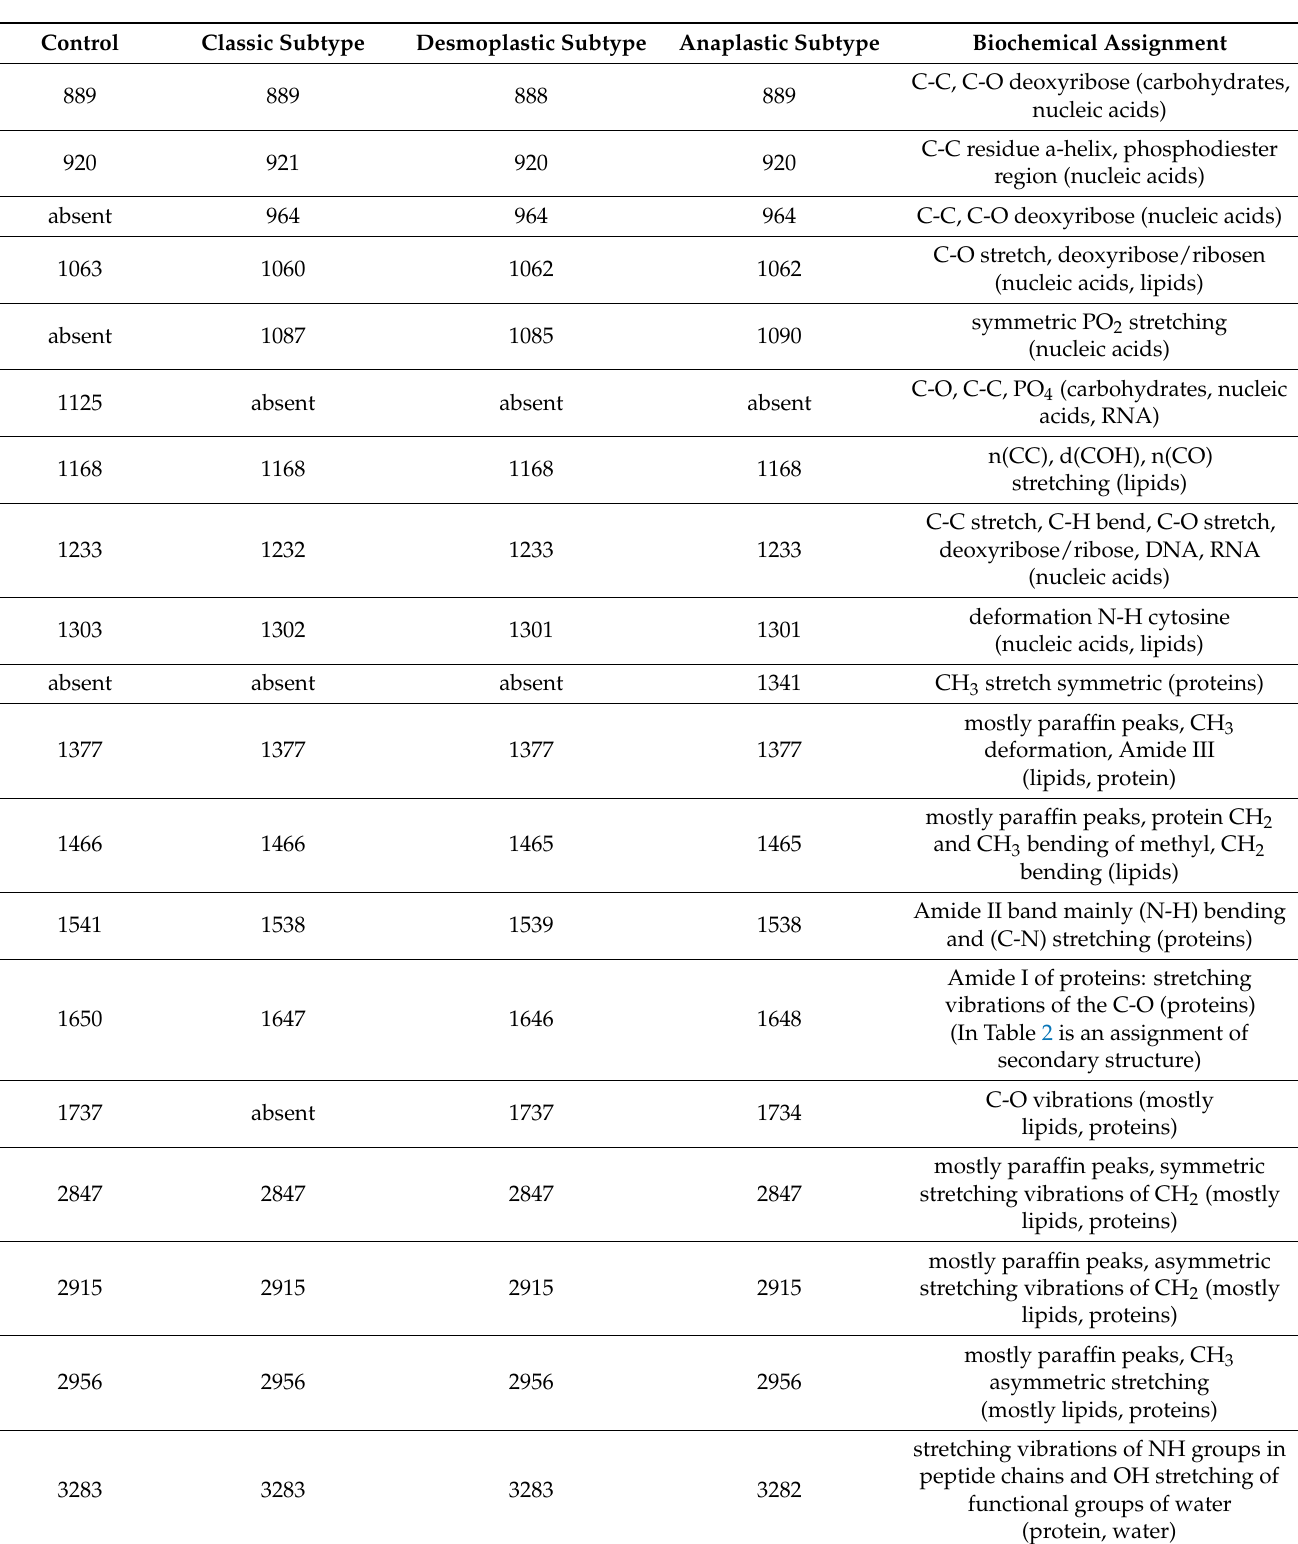
Table 1. Peak vibrational frequencies observed in the FTIR spectra of the different histological subtypes in FTIR spectra and their associated biochemical assignments